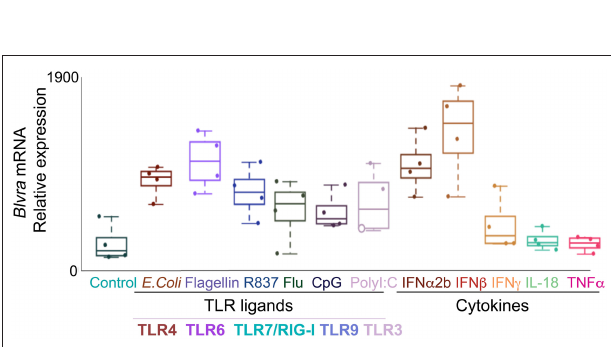
FIGURE 4 | Expression of BLVR-A in human leukocytes. qPCR analysis of BLVR-A in peripheral blood mononuclear cells after stimulation with toll-like receptor ligands and cytokines. Results represent the mean ±